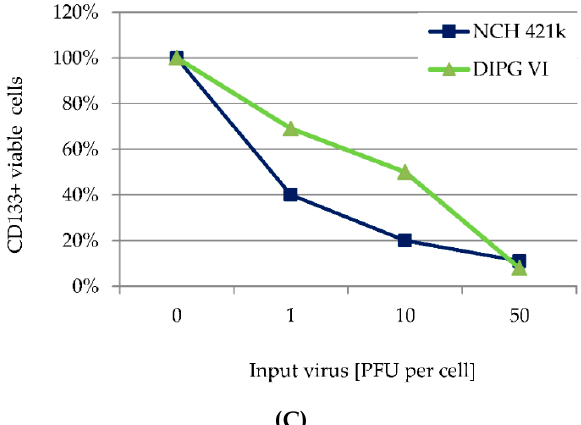
Figure 5. H ‐ 1V infection is cytotoxic to Nestin and CD133 positive cells. ( A ) Immunofluorescence of two HGG neurosphere cell lines infected with one PFU per cell nine days post seeding, which corresponds to three days post infection. Nuclei of the cells were stained with Hoechst 33342 ( blue ), NS ‐ 1 ( red ), Nestin ( green ) and images were merged, 400× magnification. Foci of NS ‐ 1 expression colocalize to nuclear staining with Hoechst in Nestin positive cells; ( B ) Cytotoxic effects of H ‐ 1PV on CD133 ‐ positive cells were assessed by FACS determination of the virus dose ‐ dependent induction of CD133+ cell number at day three after infection. The isotype control was performed using uninfected cells ( cyan ); ( C ) 7AAD negative, i.e. , viable cells of two HGG neurosphere cell cultures as determined by FACS nine days post infection with H ‐ 1PV at the MOIs indicated.